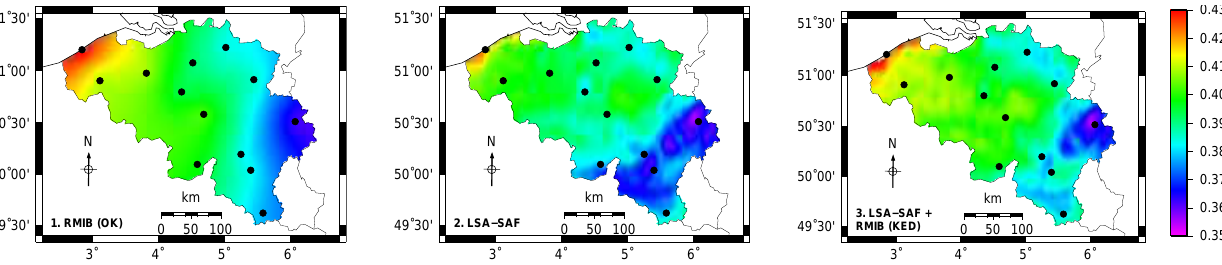
Figure 3. Spatial distribution over Belgium of the average daily clearness index as computed (1) by the OK interpolation of ground data, (2) by the single use of satellite-based estimations, and (3) by the KED merging of ground and satellite data. The displayed values of the daily clearness index are averages on the 491 days selected in this study. Dots indicate the ground stations’ locations.